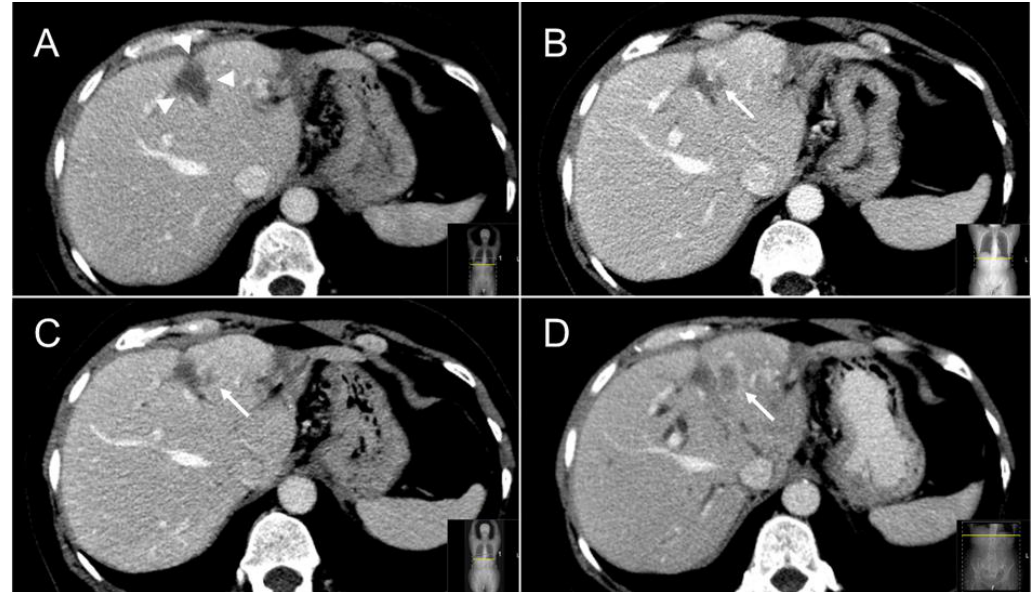
Figure 6. Follow-up cross-sectional ceCT images of a CRLM treated with thermal ablation. At six months a typical sharply demarcated hypoattenuating scar lesion (white arrowheads) is visible ( A ). At 12 months a characteristic “incomplete ring sign” (white arrow) at the left margin of the ablation zone can be appreciated ( B ), which, especially when combined with 18F-FDG avidity, is highly specific for local tumor progression following thermal ablation. Follow-up ceCT at 15 and 18 months ( C , D ) further confirmed local tumor progression.